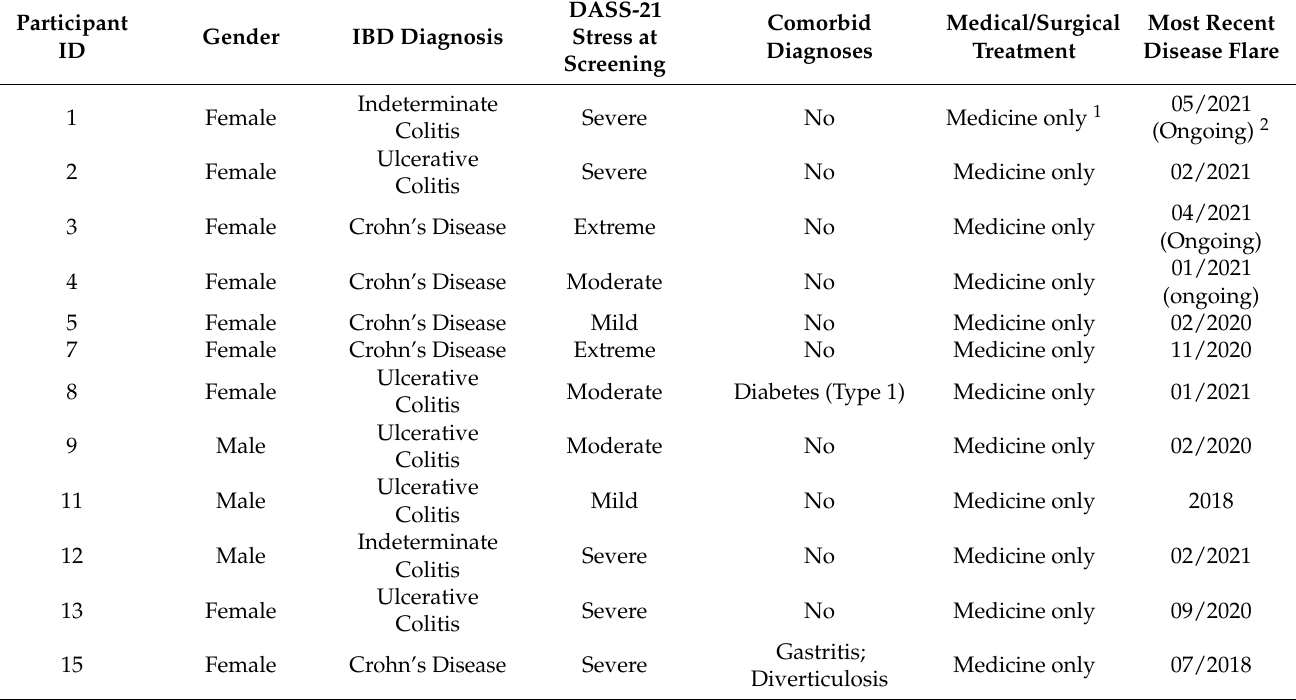
Table 6. Participant gender, IBD diagnosis, and DASS-measured stress at